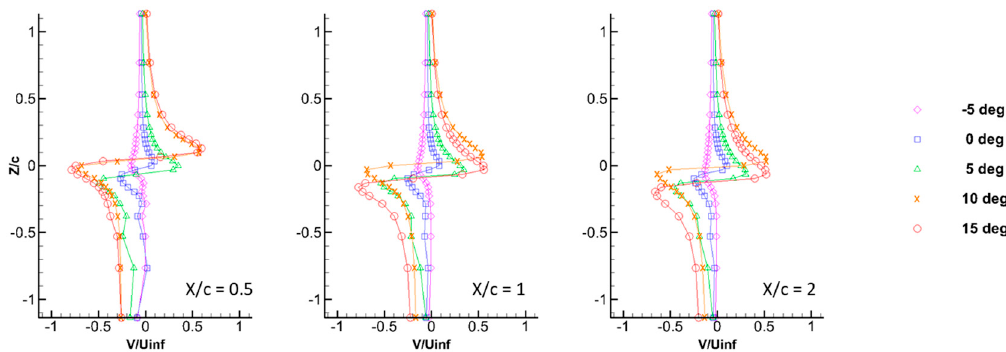
Figure 12. Line plots of time-averaged normal velocity at the vortex core.